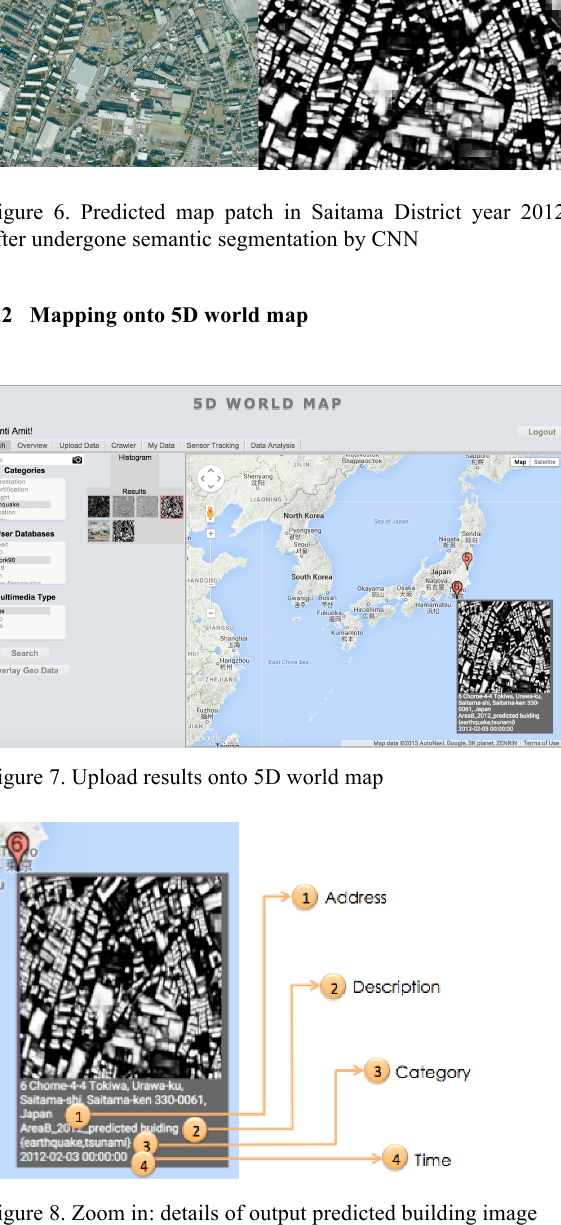
Figure 8. Zoom in: details of output predicted building image